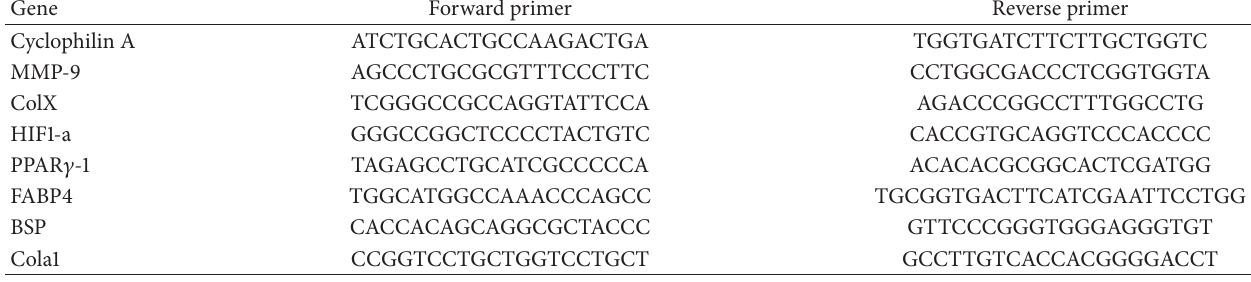
Table 2: Primer pairs used in this study.